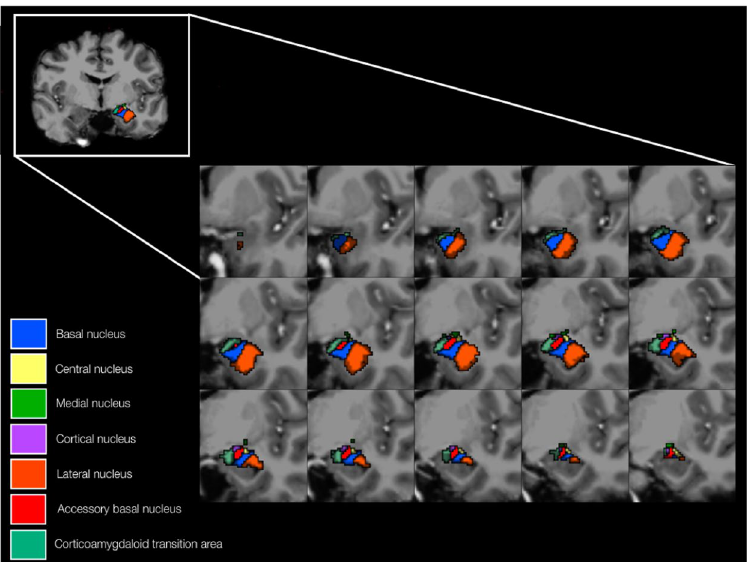
Figure 2. An anatomical representation of the segmented amygdala nuclei, including the superficial structures (central, medial and cortical nuclei), the deep structures (basal, lateral and accessory basal nuclei) and the corticoamygdaloid transition area. The volumes of the lateral nucleus, cortical nucleus, accessory basal nucleus and corticoamygdaloid transition area displayed significant negative associations with MDD severity.